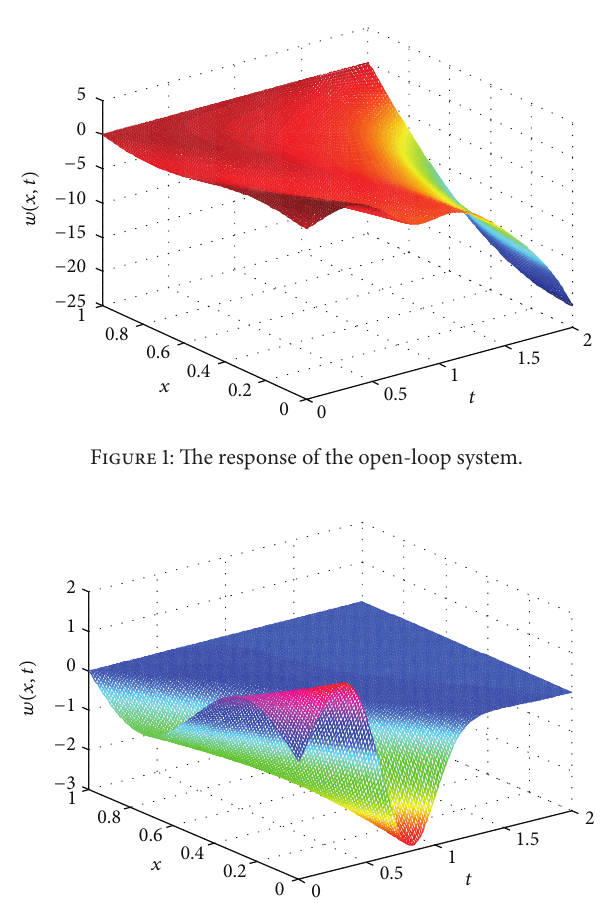
Figure 2: The response of the closed-loop system ( 𝛾 = 4.5